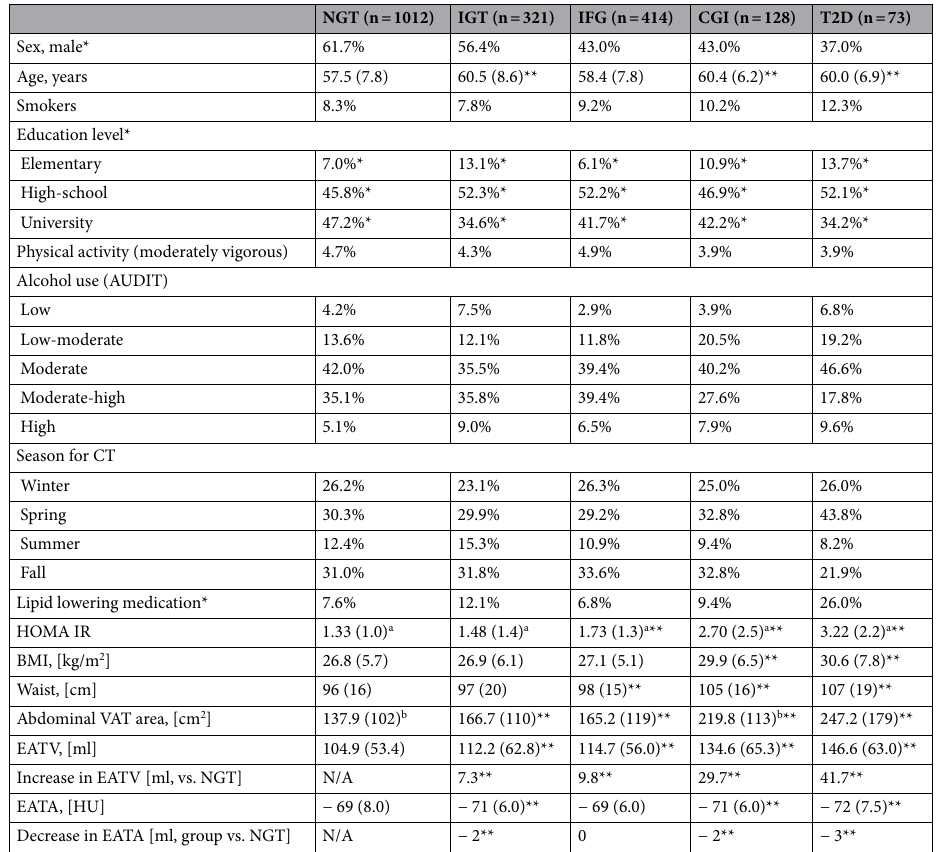
statistically significant differences. *p < 0.05 [Pearson Chi-square test for differences between glucose groups] **p < 0.05 [Independent Samples Kruskal–Wallis Test, group vs. NGT]. a 13 + 4 + 8 + 1 + 2 = 28 cases of